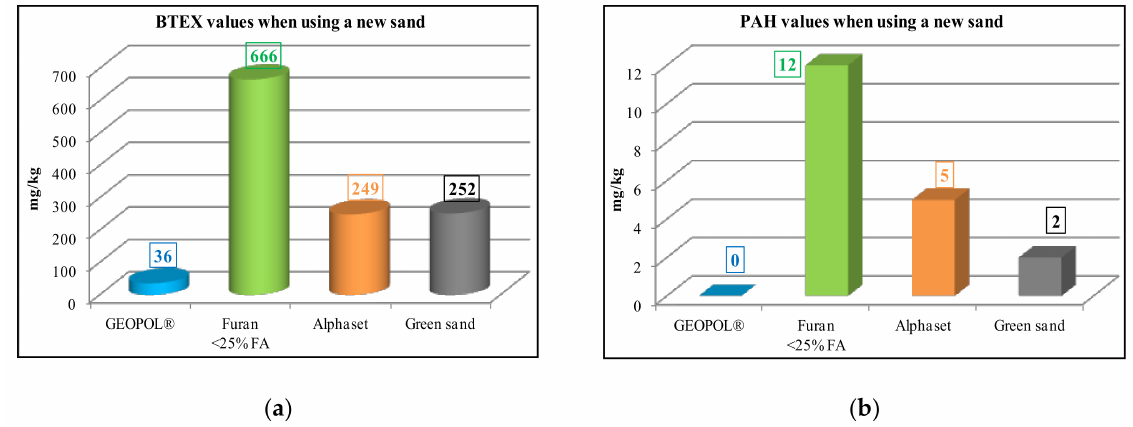
Figure 1. Comparison of ecological performance of organic and inorganic binder system during pouring: ( a ) BTEX values and ( b ) PAH values